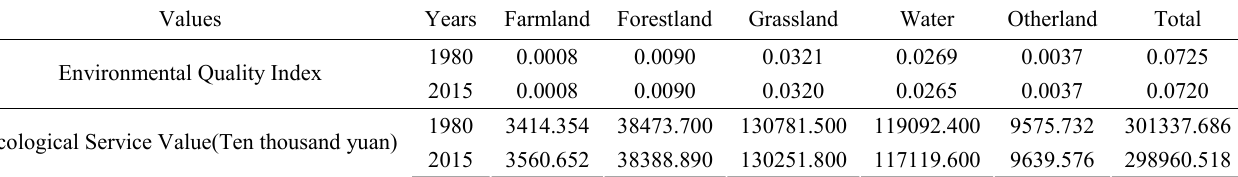
Tab.5 Environmental Quality Index and Ecological Service Value in 1980 and